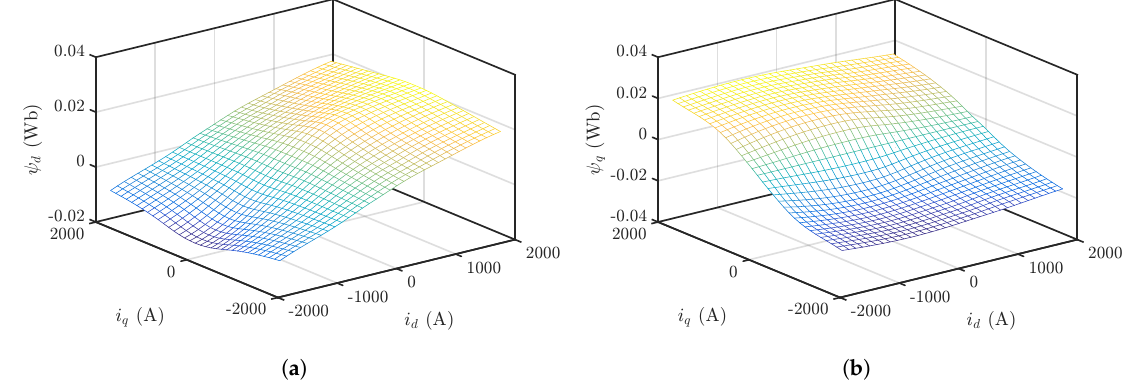
Figure 3. Original flux-linkage map for ( a ) d -axis and ( b ) q -axis flux